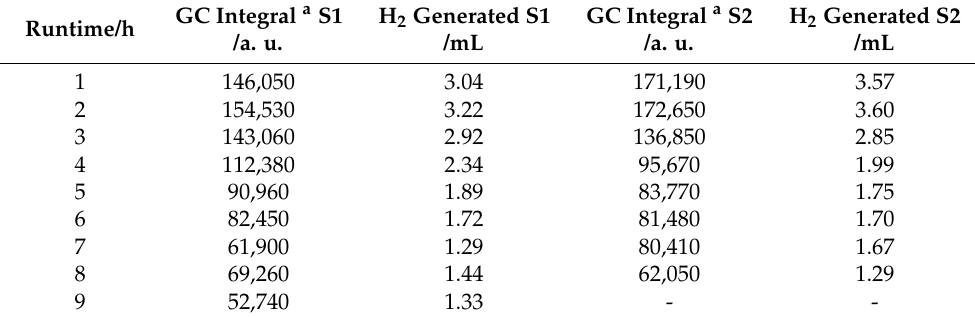
Table 5. Performed hourly kinetic dihydrogen generating experiment of two sample vials.